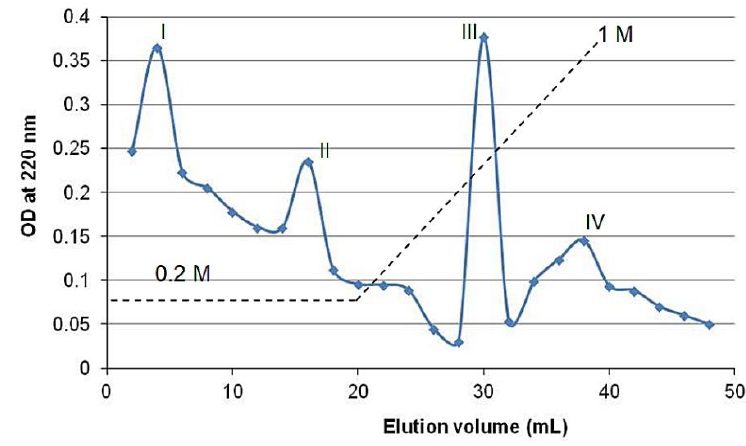
Figure 8. Ion exchange chromatography of FBBP on CM-Sephadex using 0.2 – 1 M NaCl gradient.